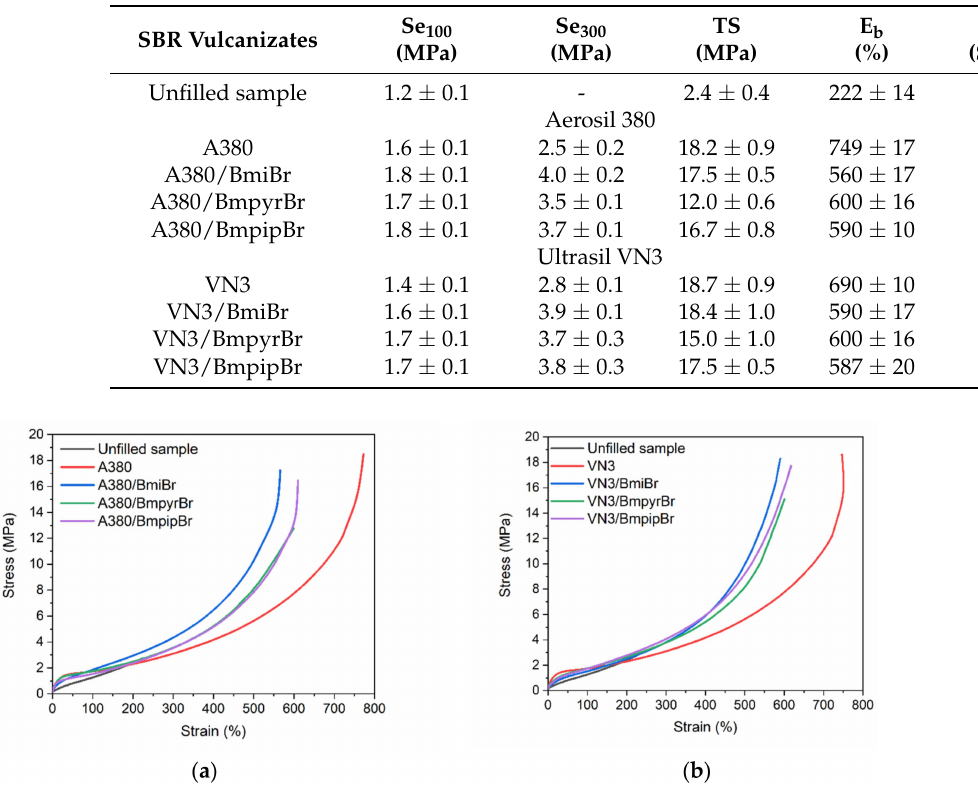
Figure 6. Stress–strain curves of SBR vulcanizates filled with: ( a ) A380; ( b ) VN3. Analyzing the data collected in Table 6, no significant influence of the specific surface area of silica on the stress at a relative elongation of 100% and 300% (Se 100 , Se 300 , respectively) was observed. However, due to the incorporation of the filler, silica-filled SBR vulcanizates exhibited slightly higher Se 100 compared to the unfilled sample. Addition of ILs, especially BmiBr, increased the Se 300 by approximately 1 MPa as compared to the vulcanizates without ILs. This resulted from the higher crosslink density of the vulcanizates containing